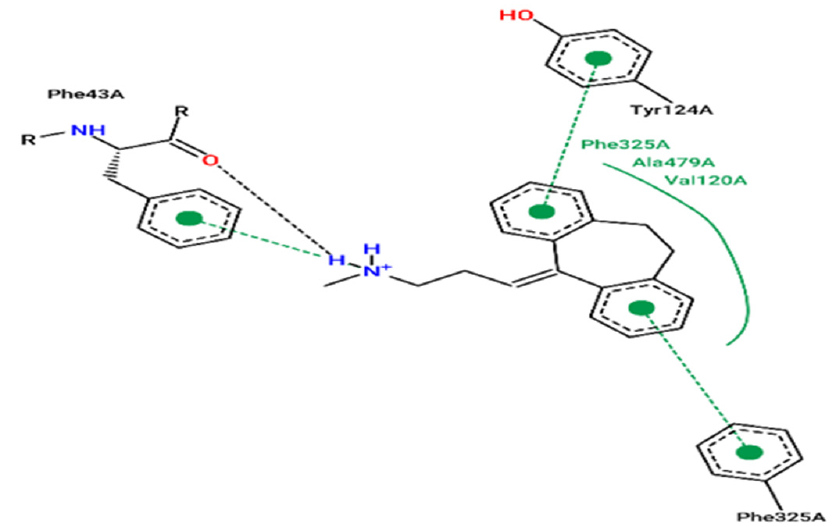
Figure 7. Experimental pose view of Nortriptyline with the protein’s active sites.